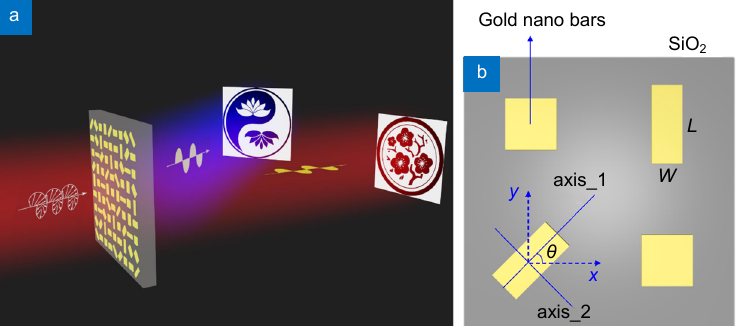
Fig. 1 | ( a ) Schematics illustrating the principle and structural design of a metasurface. A uniform planar wave with right circular polarization is irradiated on the metasurface of spatial structural changes, the emitted light field will therefore carry varying amplitude and polarization in space. Intensity distribution is different in two orthogonal polarization components, so the patterns detected at different polarization angles will be different as shown in the left graphic. For viewing purpose, two images are staggered in diagram, but in reality, they are in the same position. ( b ) Front view of part of the metasurface, the nano bars are made of gold with varied sizes and rotations, the substrate is SiO 2 with refractive index